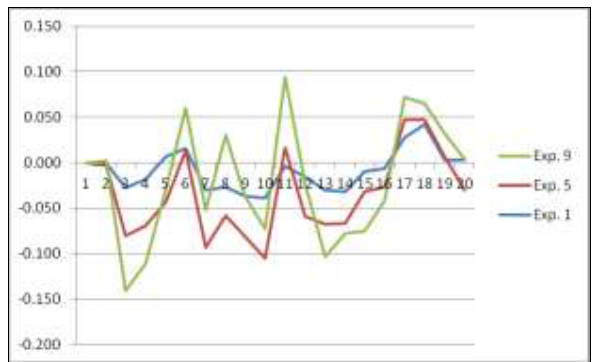
Figure 4 – Z C absolute error at each PC.